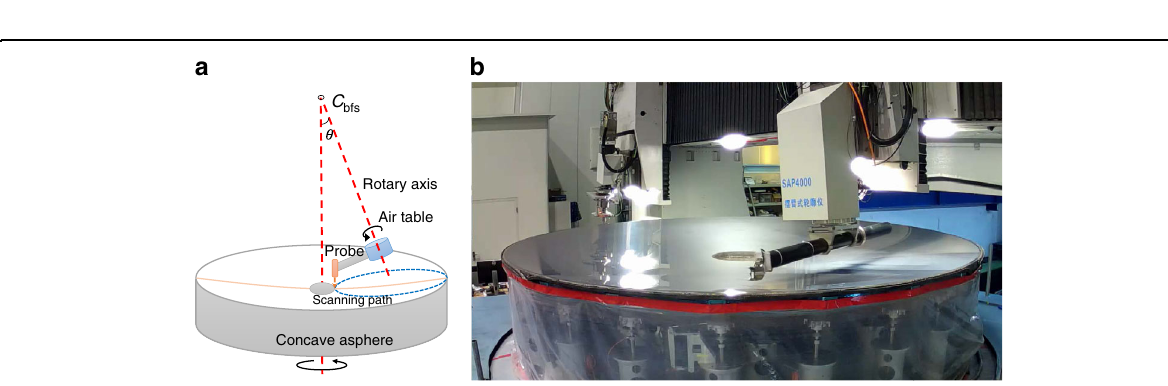
Fig. 16 SAP test of the ⌀ 4.03 m aspherical mirror tested. a Schematic diagram of SAP testing method 44 . b Built-in SAP testing